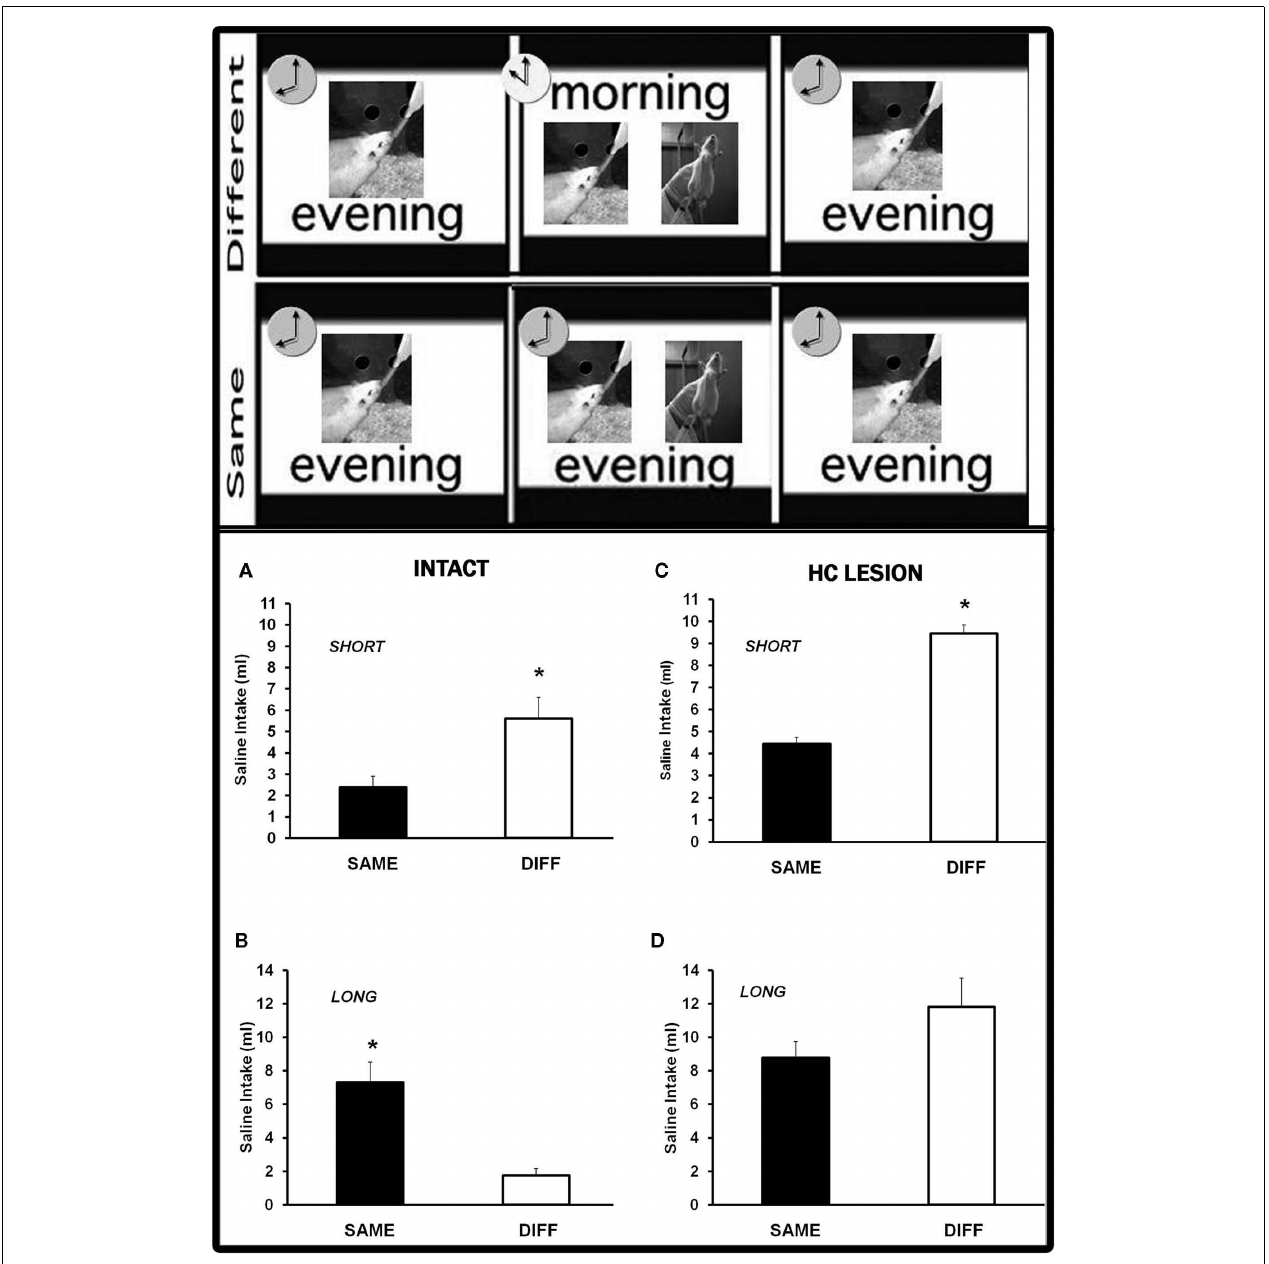
panel – two different protocols were applied depending on the extent of the habituation phase: a short-habituation (2days) or a long-habituation (5days) protocol.The time-of-day shift induced opposite patterns of results in intact rats subjected either to the short (A) or the long (B) protocol. Hippocampal lesions impaired the effect of a temporal context shift in the long (D) but not the short (C) behavioral protocol. (For further details see Moron et al., 2002b; Manrique et al., 2004, 2009; Molero et al.,